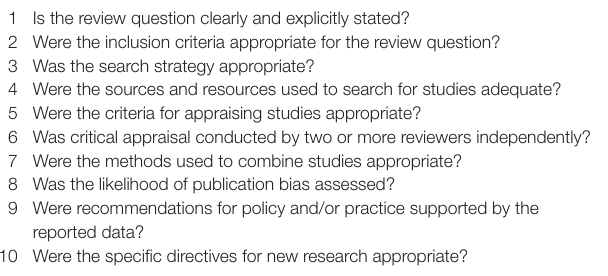
TaBle 1 | Critical Appraisal Checklist for Systematic